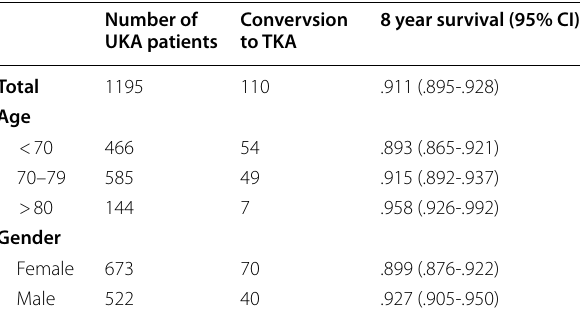
Table 11 8 year UKA implant survival by age and gender (with a minumum 8 year follow up) Number of Convervsion UKA patients to